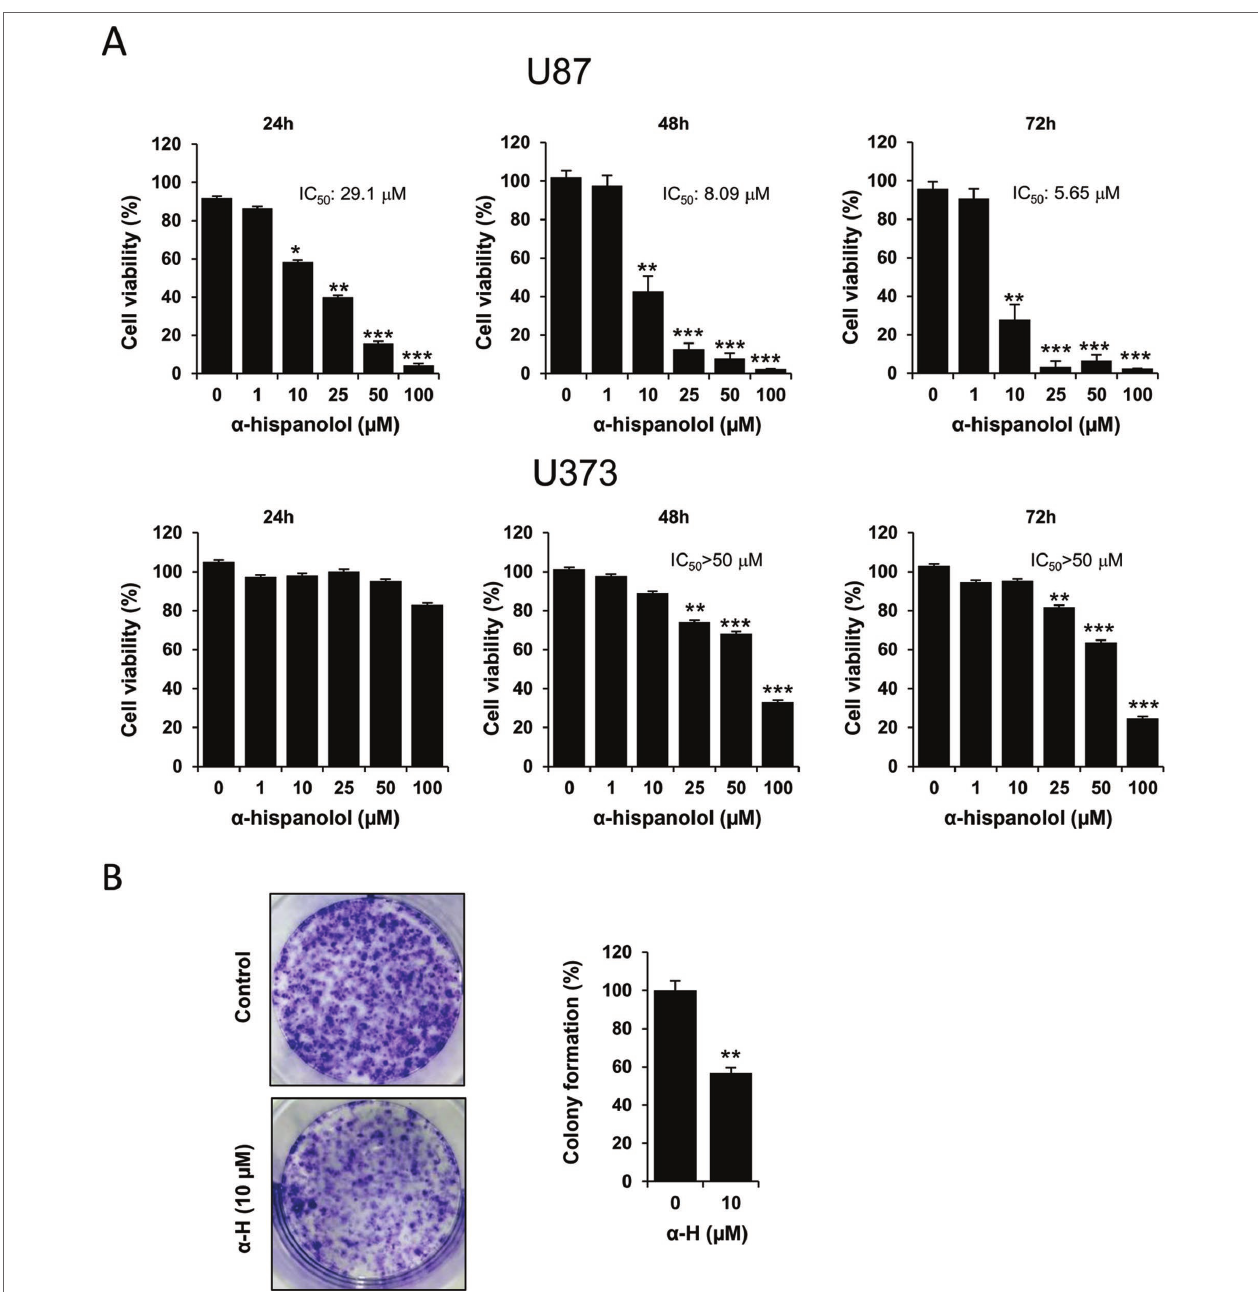
FIGURE 1 | α -H inhibited proliferation and suppressed colony formation in glioblastoma cells. (A) U87 and U373 cells were treated with different concentrations of α -H (1–100 μM) for 24, 48, and 72 h. Cell viability was determined by MTT assay and reported as mean of the cell viability percentage ± S.D. from at least three independent experiments. *P < 0.05, **P < 0.01, and ***P < 0.001 with respect to control. (B) Colony formation of U87 cells treated with α -H (10 μ M) was evaluated by clonogenic assay. Representative images of crystal violet-stained cultures are shown on the left. Bar graph shows mean of the colony formation percentage ± S.D. from three independent experiments. **P < 0.01 with respect to vehicle-treated